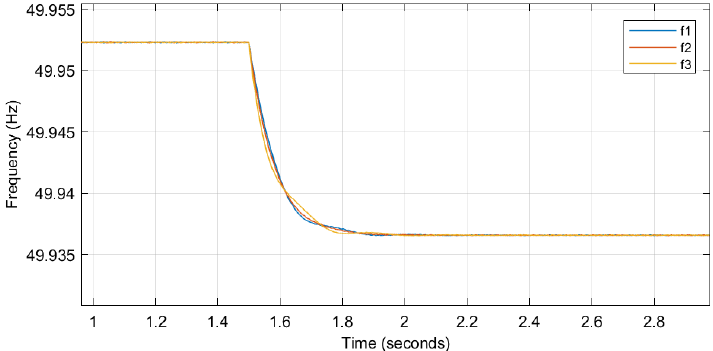
Figure 17. Frequency output of the droop controller with proposed virtual impedance.